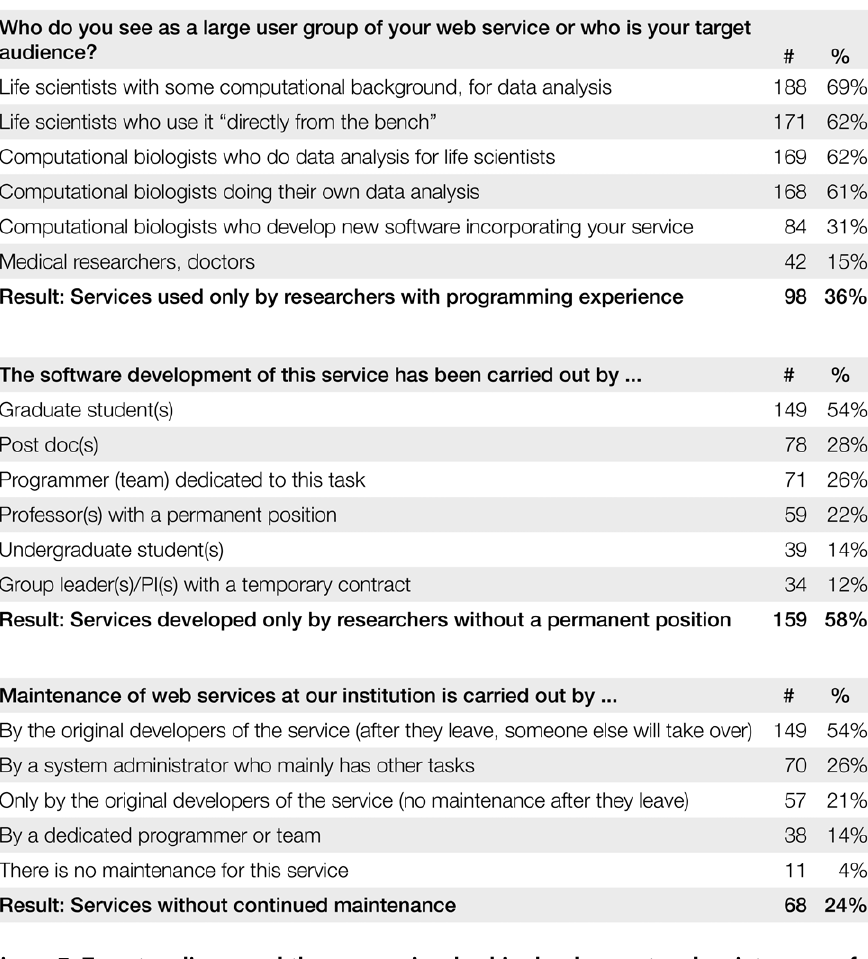
Figure 7. Target audience and the persons involved in development and maintenance of a Web service. In our survey among 274 authors, we asked about their service’s expected users. Multiple answers were possible. The most interesting result of the first question is that Web services are indeed intended for researchers without programming experience, only 36% of services are used solely by researchers with a programming background, as estimated by the respondents. The second question indicates that services are rarely funded by separate grants, and development is carried out by researchers with a temporary position, such as graduate students, post-docs, etc., in 58% of all cases. The third question reveals that by the time of this survey, about 24% of services will soon lack persons maintaining them. 13 respondents (5%) indicated that they are going to maintain the service even after moving to another institution.